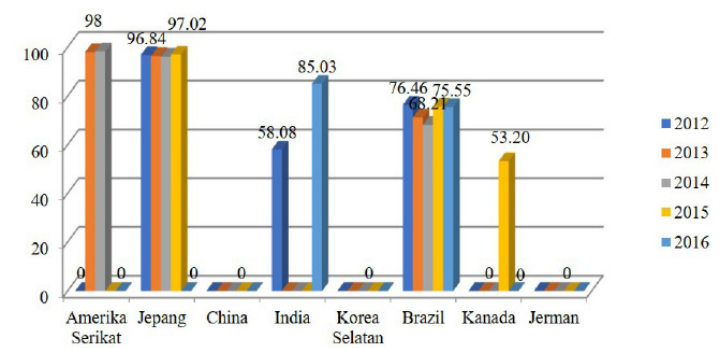
Figure 4: Coverage Ratio TBT(%) at Natural Rubber Export TSNR to Major Destination Coun - tries